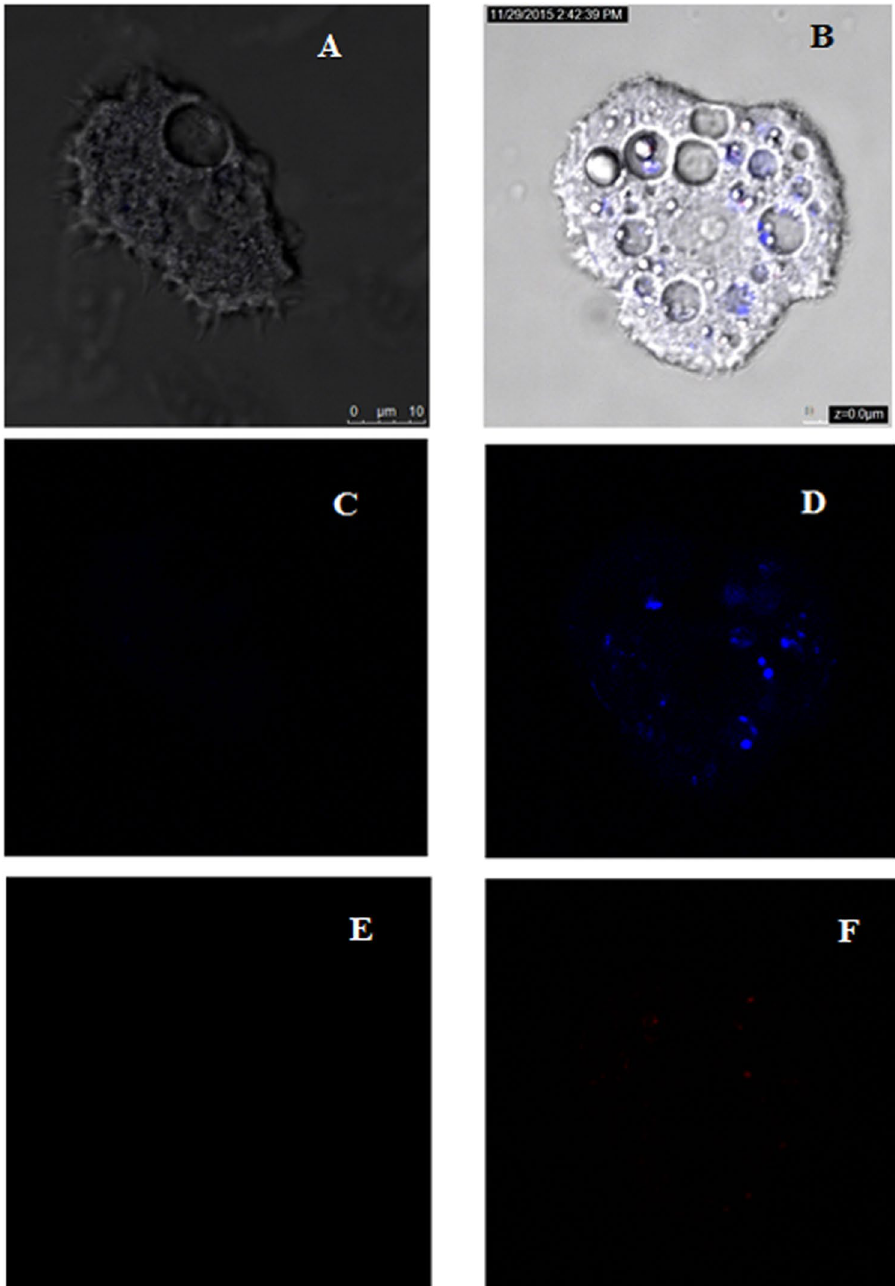
Figure 3. Hoechst staining is different in control cells, where uniformly faint-blue nuclei are observed, and in treated cells, where the nuclei are bright blue. ( A to C ) Overlay images: control (24 h) ( A ), Systane Ultra IC 50 (24 h) ( B ), Systane Ultra IC 90 (24 h). ( D – F ) Hoechst channel: control (24 h) ( D ), Systane Ultra IC 50 (24 h) ( E ), Systane Ultra IC 90 (24 h) ( F ). ( G to I ) Propidium iodine channel: control (24 h) ( G ), Systane Ultra IC 50 (24 h) ( H ), Systane Ultra IC 90 (24 h) ( I ). (Magnification of